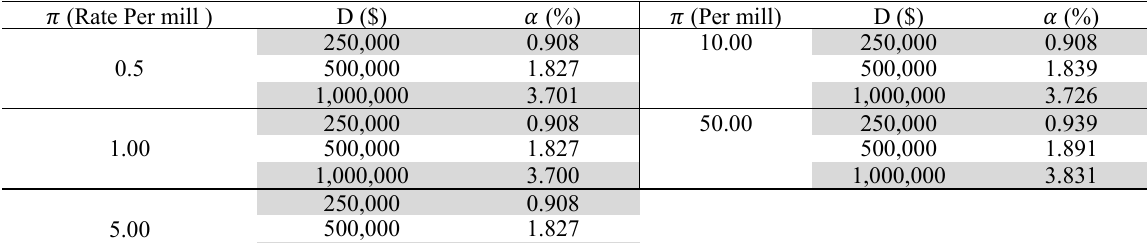
Calculation of α for different values of (cid:2024) and